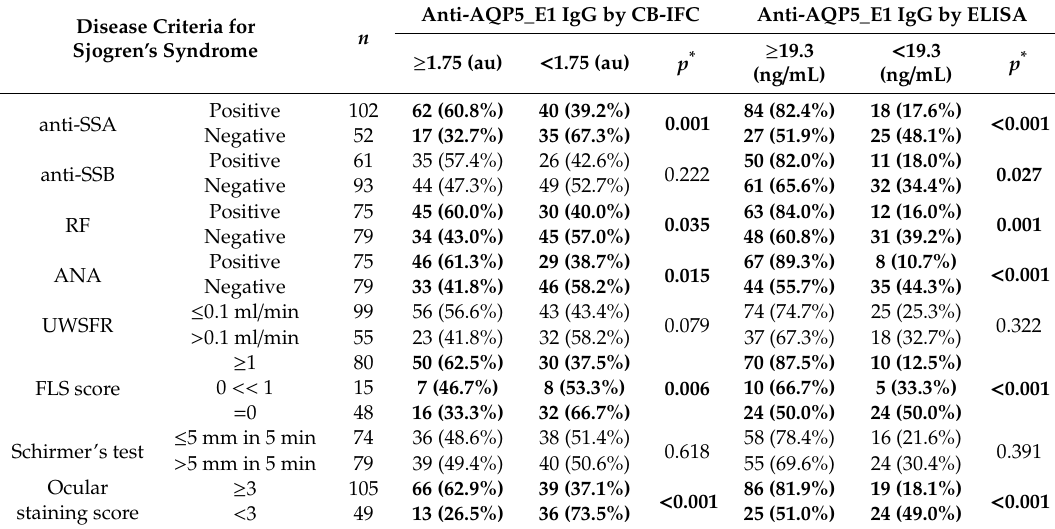
Table 3. Bivariate analysis exploring the presence of anti-AQP5_E1 IgG by disease criteria for Sjögren’s syndrome in 154 SICCA registry